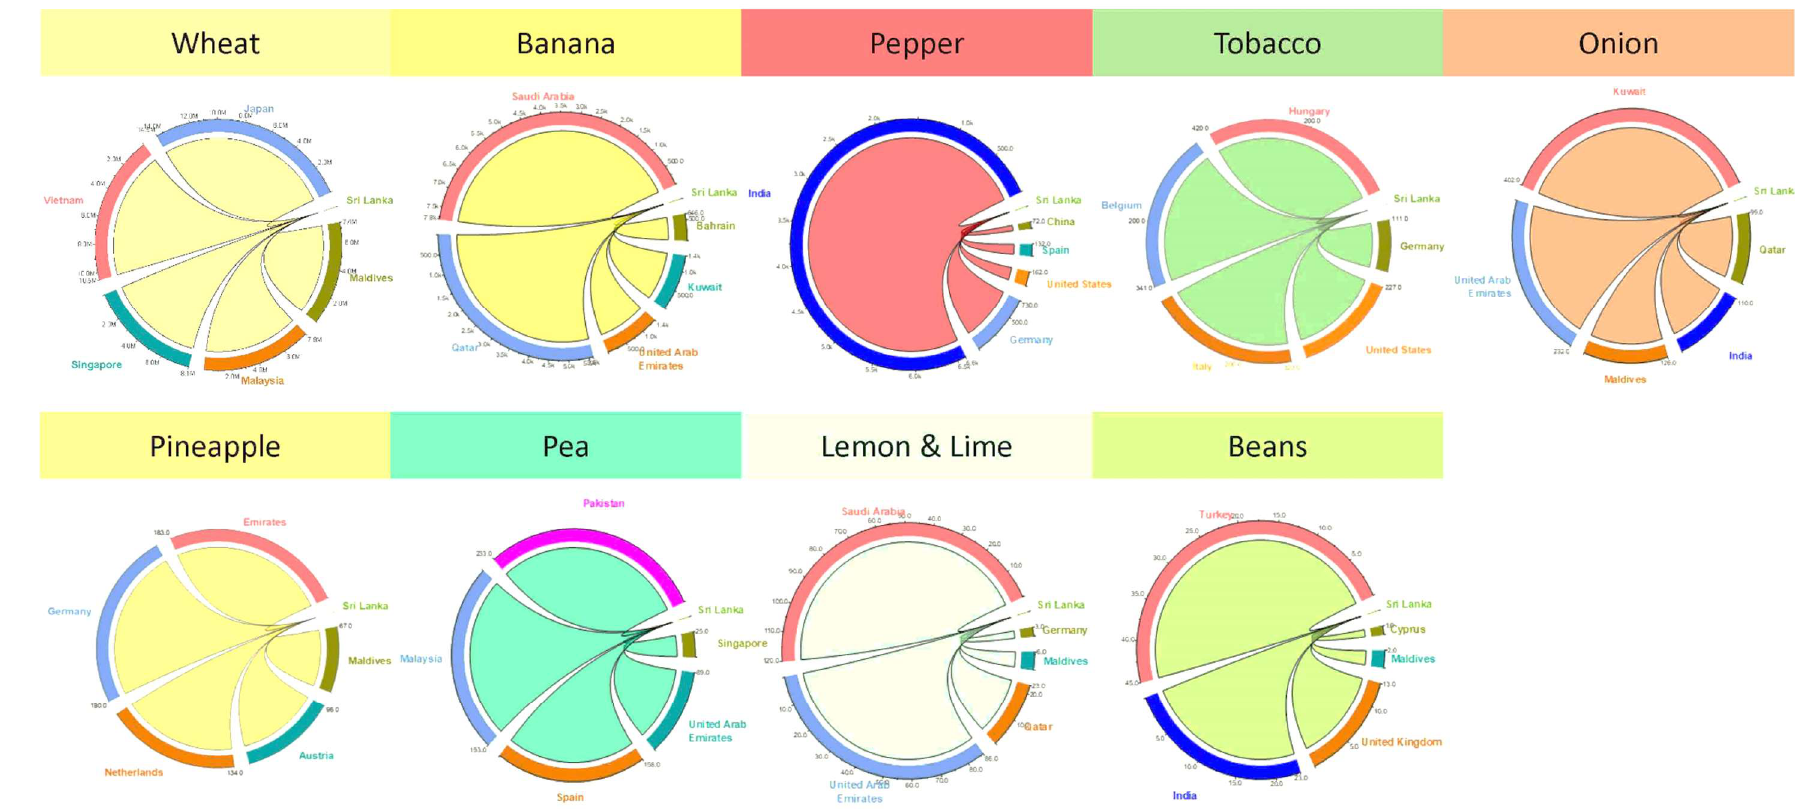
Figure 10. Top nine crops of Sri Lanka and their export details based on trade data